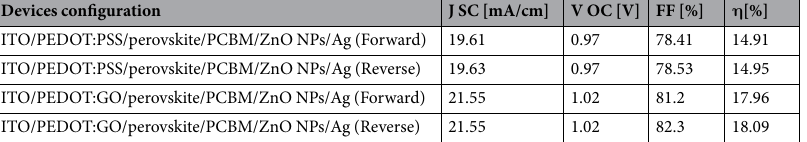
Table 1. Summary of the device performance of perovskite solar cells with PEDOT:PSS and PEDOT:GO composite film under forward and reverse bias.